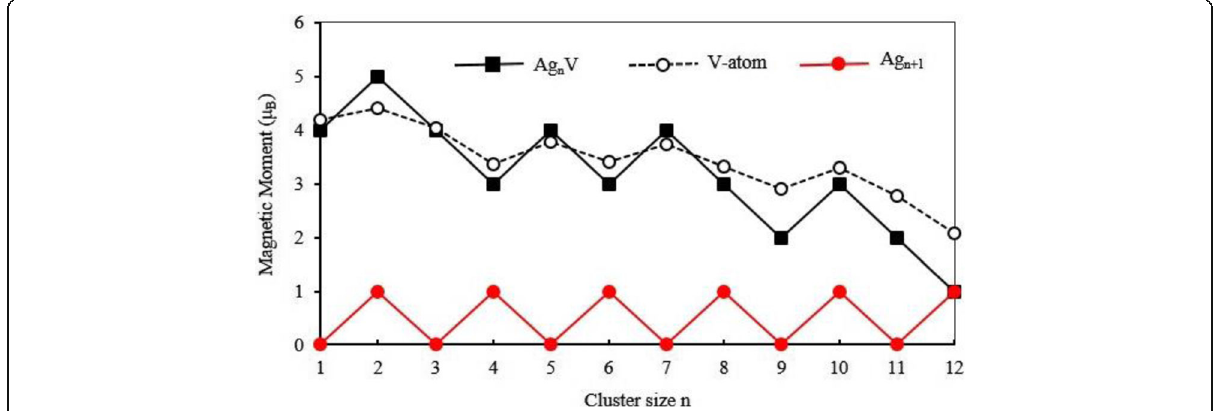
Fig. 7 Total magnetic moment of the ground state Ag n +1 and Ag n V ( n = 1 – 12) clusters and local magnetic moment on V atom